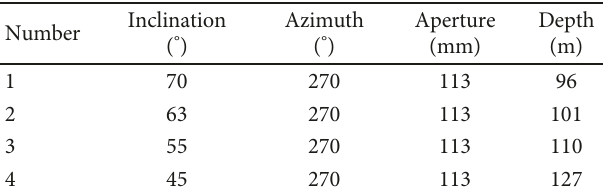
Table 7. The damage height of overburden rock in